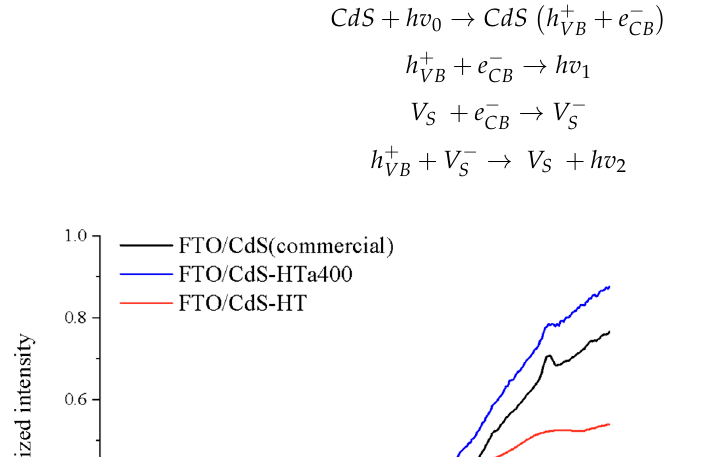
Figure 9. Photoluminescence spectra of FTO/CdS-HTa400 (blue), FTO/CdS-HT (red) and FTO/CdS (commercial,